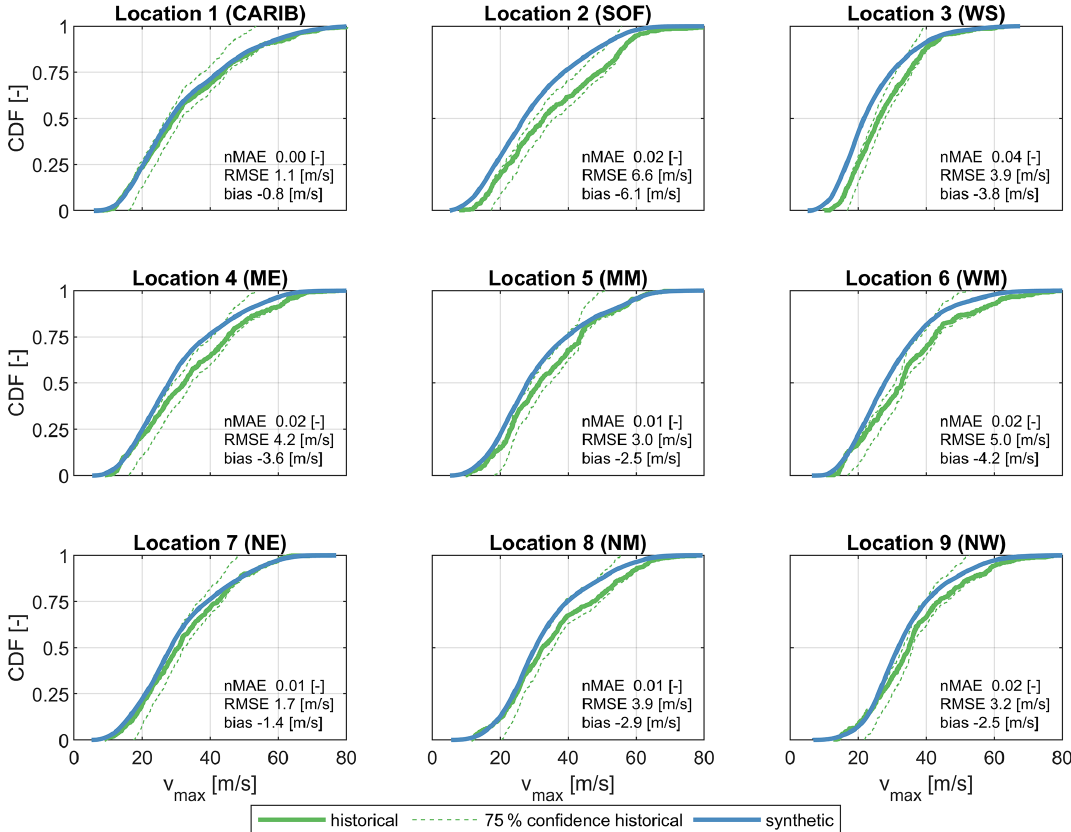
Figure 8. CDFs of maximum sustained wind speed ( v max [ms − 1 ]) of historical (green line) and synthetic (blue line) TCs at nine locations within the NA basin, as shown on the map in Fig. 2. The 75% confidence interval (dashed green line) of historical data is also shown. Historic data are based on data available between 1886 and 2019, while synthetic data are derived from 10000 years of simulated events with TCWiSE. Data points within 200km from the control location are included in the analysis for both the historical and synthetic